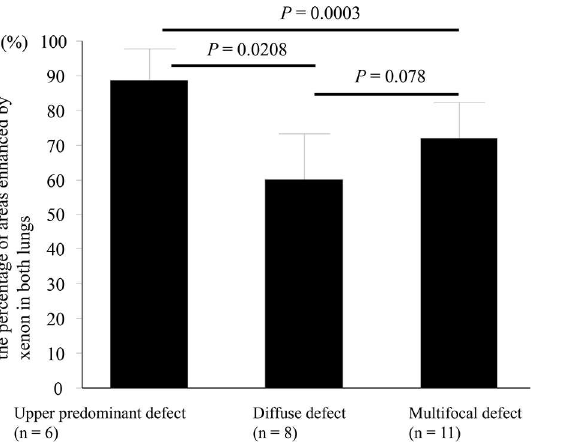
Fig 5. Comparison with the percentage of areasenhanced by xenon among 3 different patterns in CPFE. The percentage of areas enhanced by xenonin upper predominantdefect pattern was significantly higherthan that in diffuse defect ( P = 0.0208)and multifocaldefect pattern ( P = 0.0003) among3 different patterns in CPFE (one-way ANOVA with Tukeys correction for 3